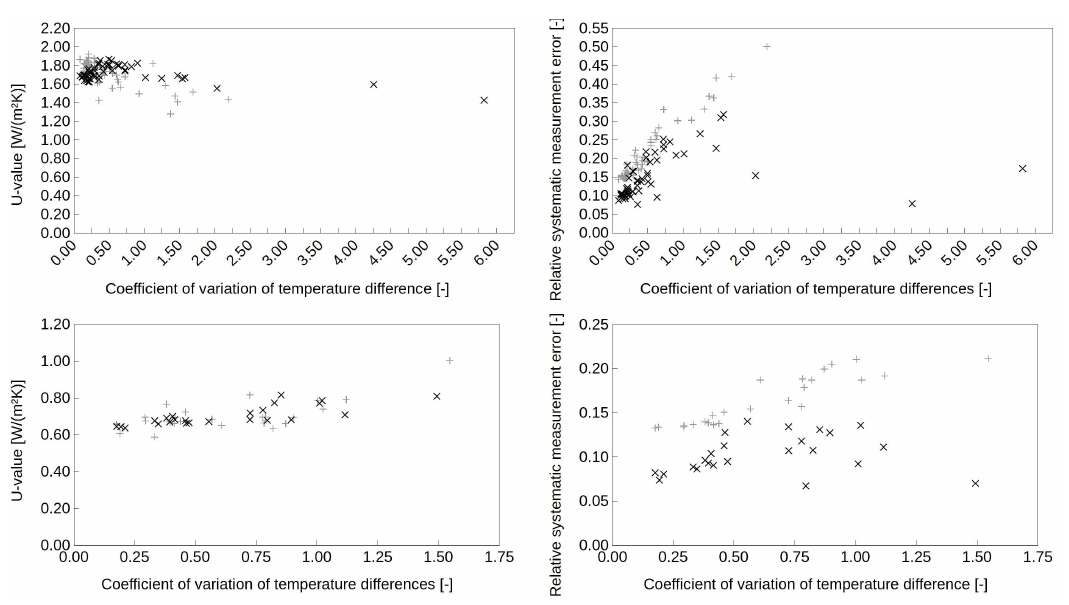
Figure 11. U -value and relative systematic measurement error estimates for the 2TM model (black x-crosses) and average method (grey crosses) as a function of the coefficient of variation of the temperature differences, for the SWall ( top ) and CWall_N ( bottom